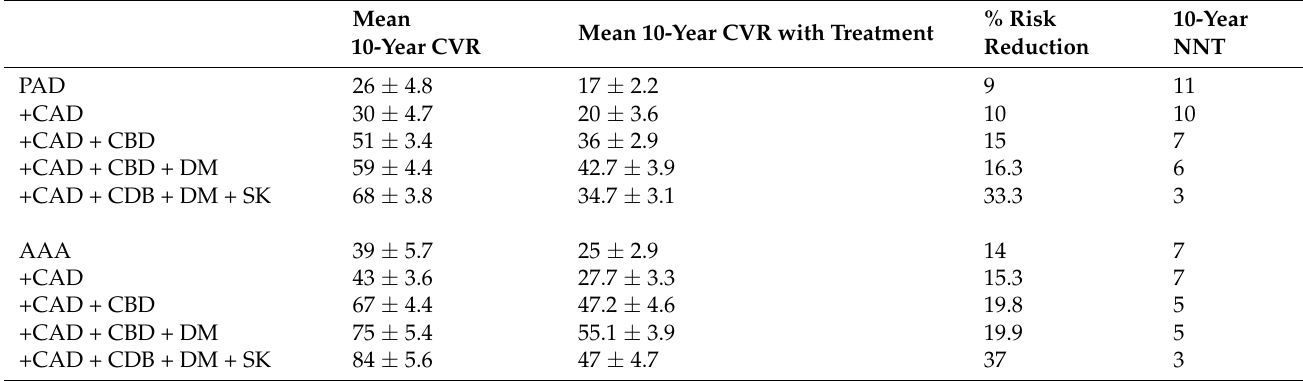
Table 3. CVR estimation with additional diseases and impact of ESC targets on risk